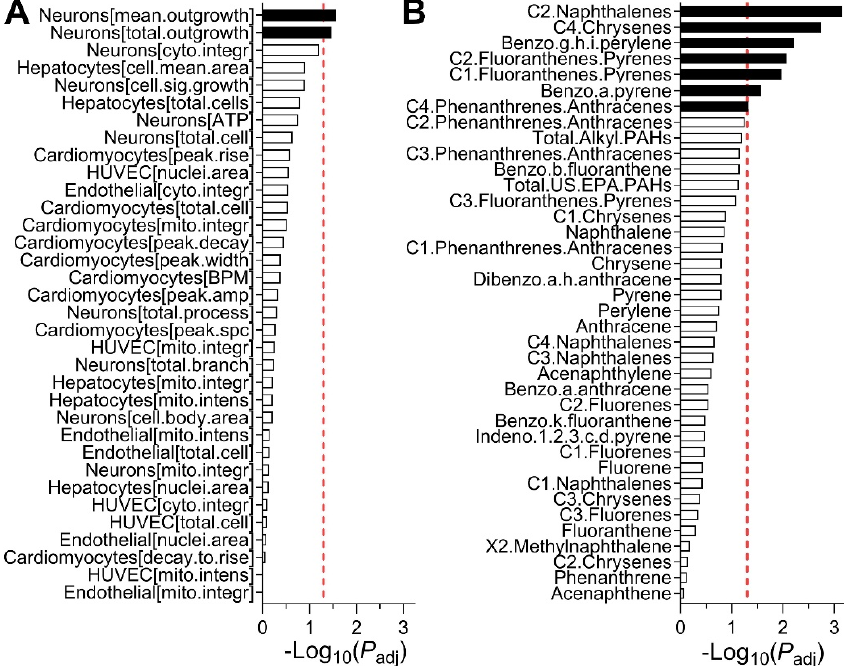
Figure 3. Spatial correlation among in vitro bioactivity (A) and PAH concentrations (B). Shown are adjusted p values (log 10 scale) for spatial correlation of each parameter and a vertical dotted line represents p adj = 0.05 (false discovery rate) threshold. These p values were derived using a modified spatial correlation method as described in text.